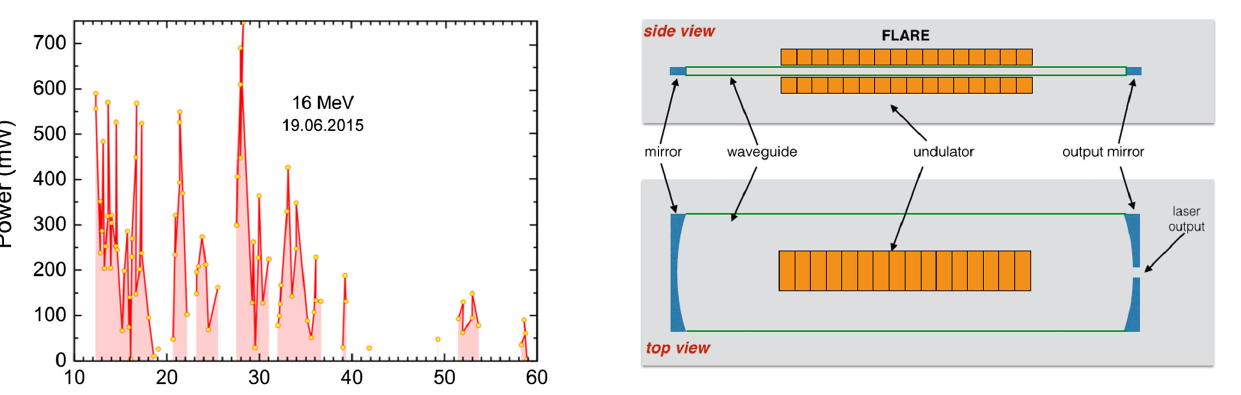
FIG. 3. Layout of FLARE Free-Electron